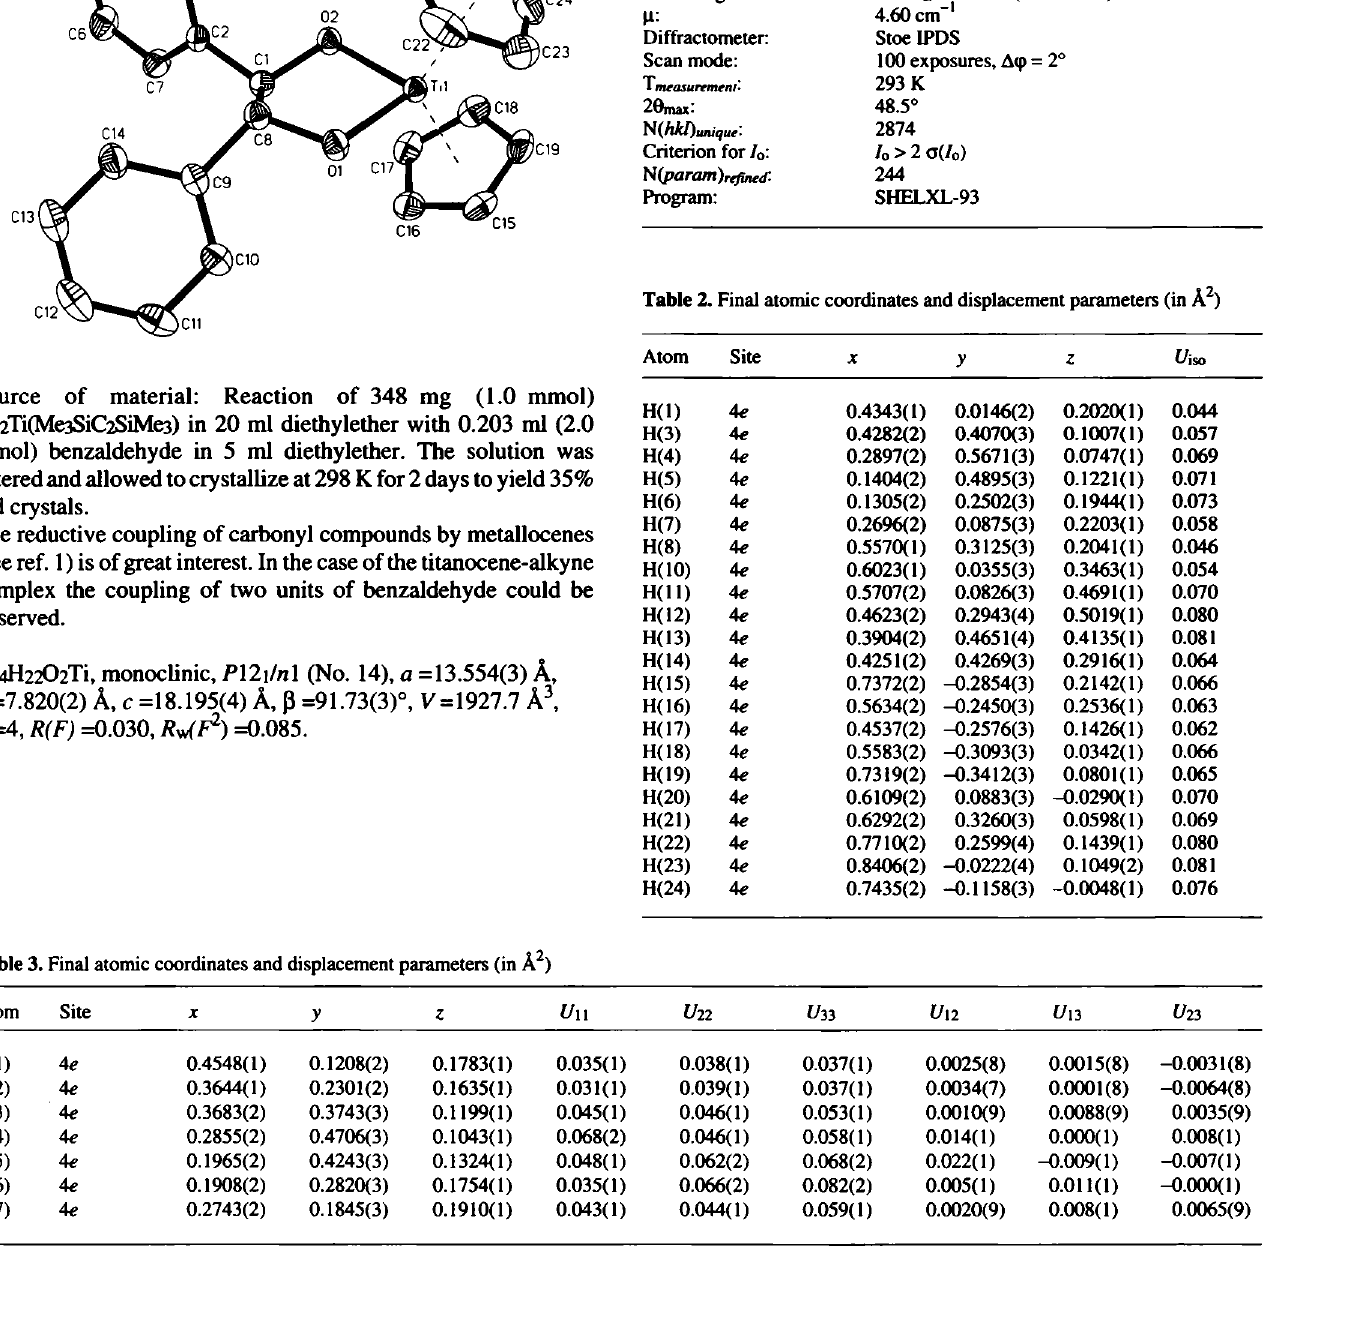
Table 1. Parameters used for the X-ray data collection